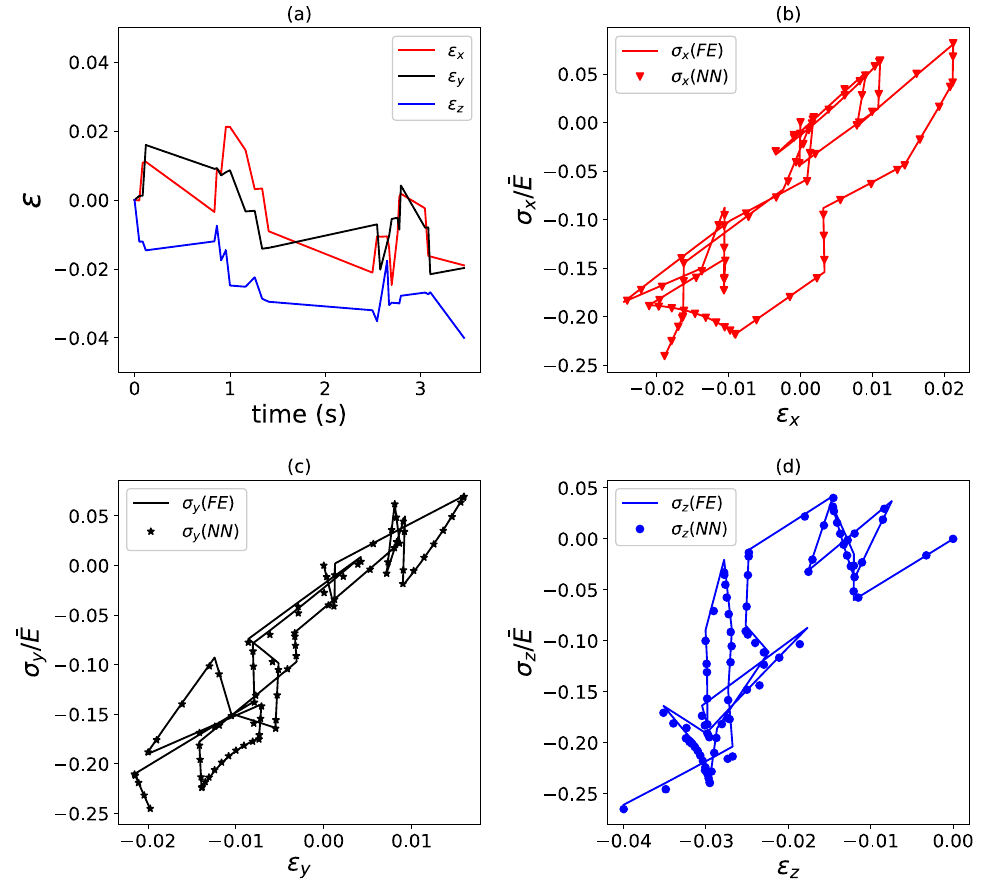
Figure 6. Example of strain versus time ( a ) and stress versus strain ( b – d ) histories for a viscoelastic composite with κ = 2.0 and stiffness relaxation dictated by a single-term Prony series. FE predictions are compared to predictions by a surrogate model. E σ = 6.2% for the load case shown, which used φ = 5000 training data